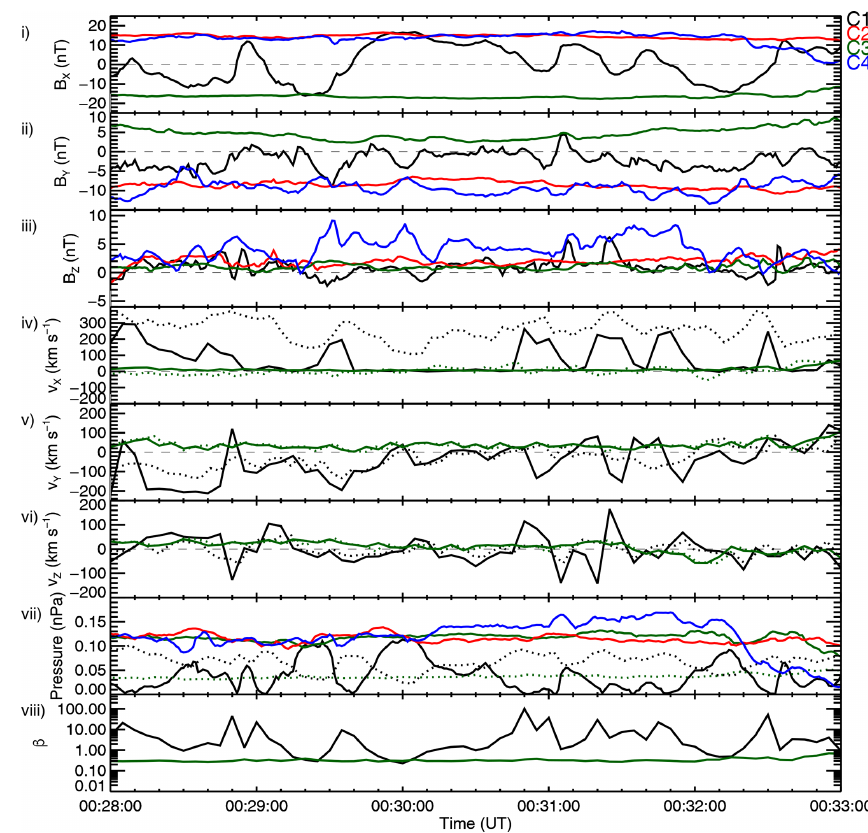
Figure 3. As in Fig. 2b but for the interval 00:28–00:33UT on 12 October 2006.